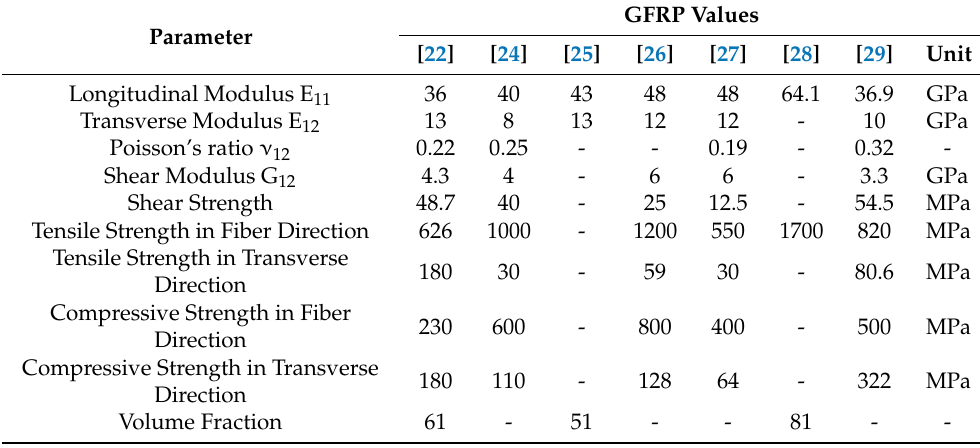
Table 2. Properties of GFRP.